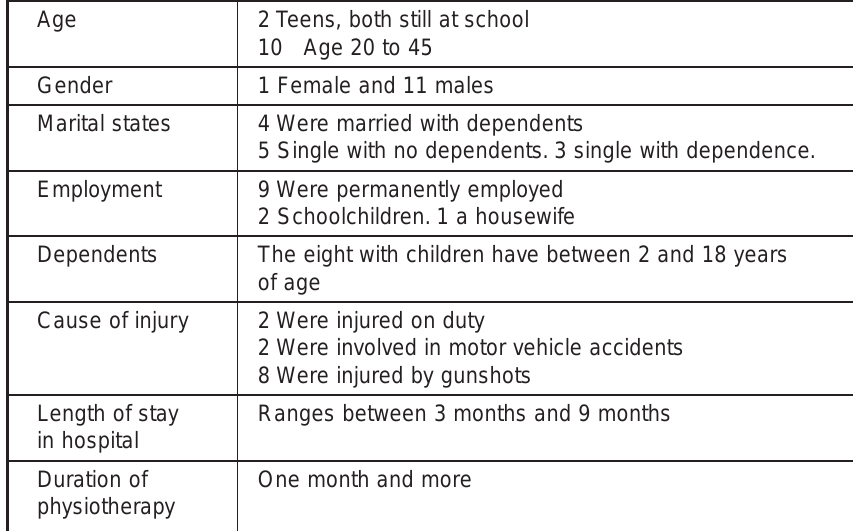
Table 1: Demographic outline of the